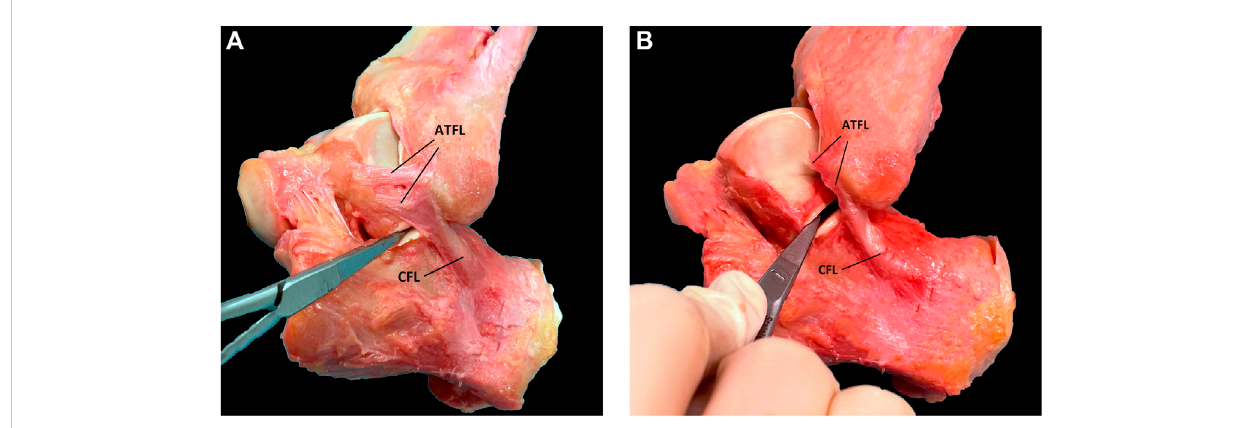
FIGURE 5 The rotational concept. (A) . Lateral view on the subtalar joint before sectioning the ATFL (B) . After sectioning the two bundles of the ATFL the talus moves in an anterior direction and the tension of the CFL decreases. This allows increased opening of the posterior facet with intact subtalar ligaments and intact